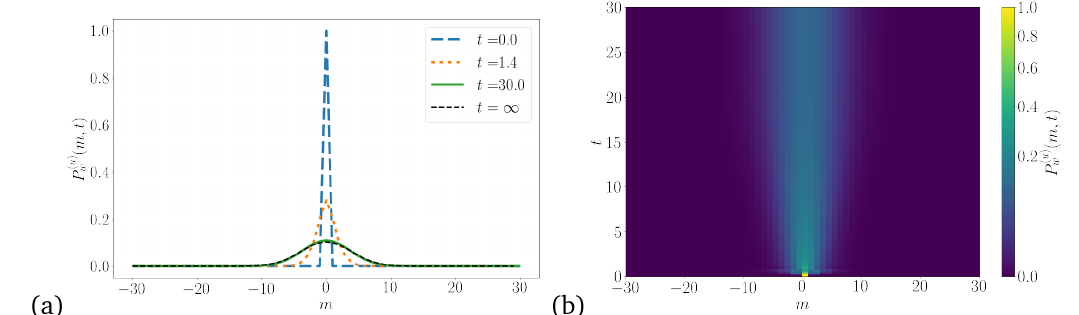
( m , t ) for a subsystem of size (cid:96) = 60 at times t = 0,1.4,30.0 for a Figure 15: P ( u ) w system initialized in a Néel state and time evolved with H ( h = 2 ) . The dotted lines are the asymptotic probability distributions given in (70).